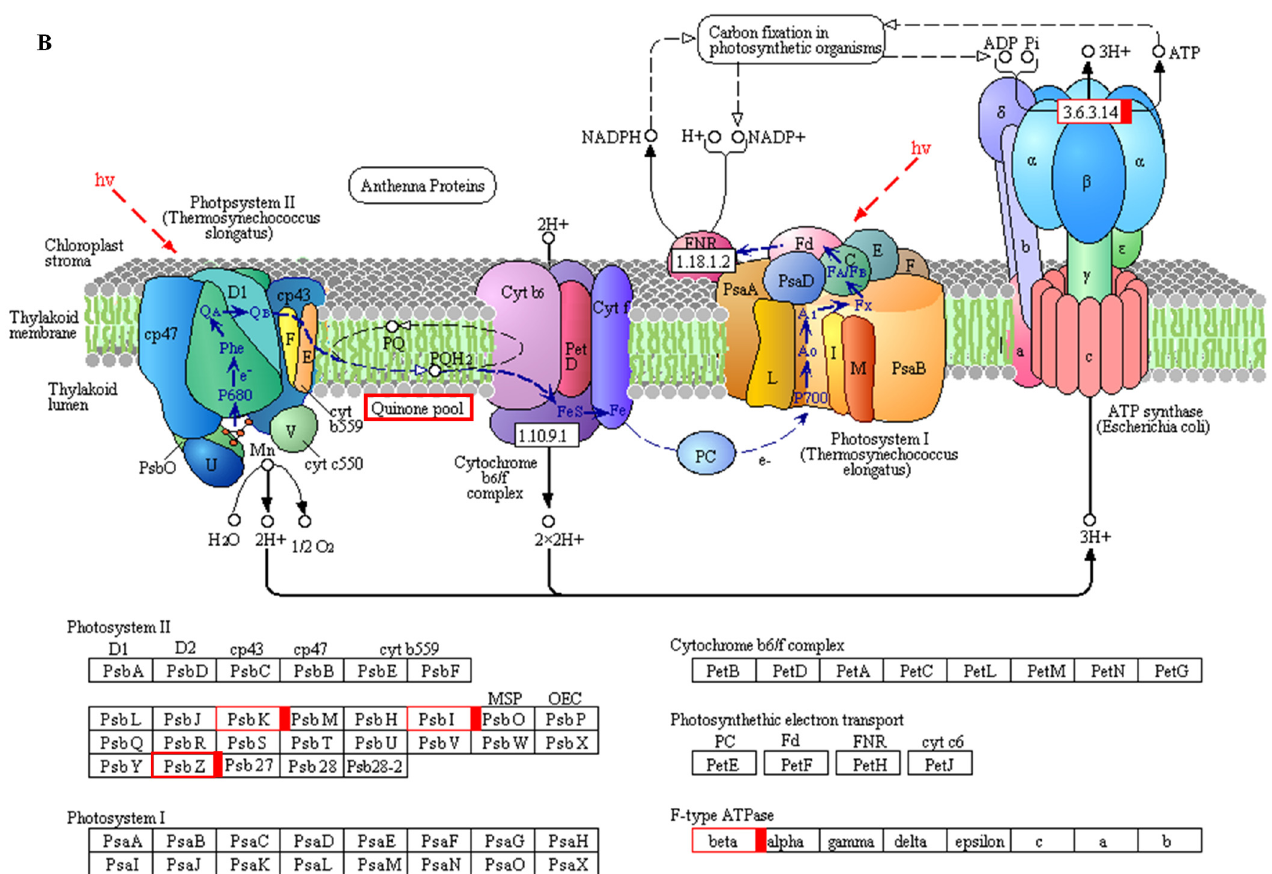
Figure 7. The DEGs involved in photosynthesis after 48 h ( A ) and 15 d ( B ) of LK stress. The red boxes indicate the protein identified in this study.